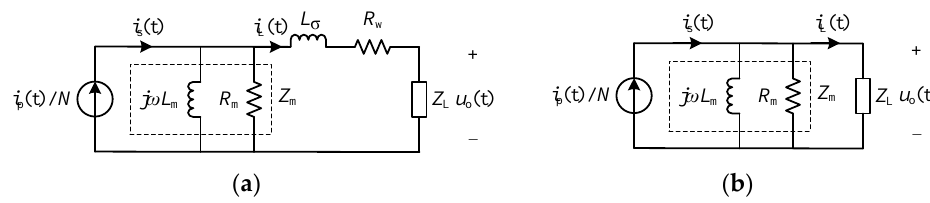
Figure 3. Non-ideal circuit model of CT. ( a ) With leak impedance. ( b ) Ignore leak impedance.